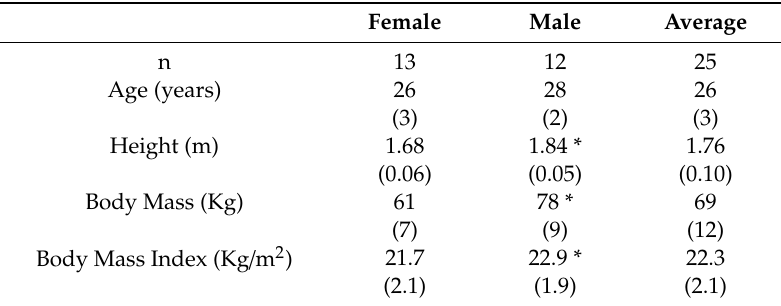
Table 1. Mean (SD) participant characteristics.